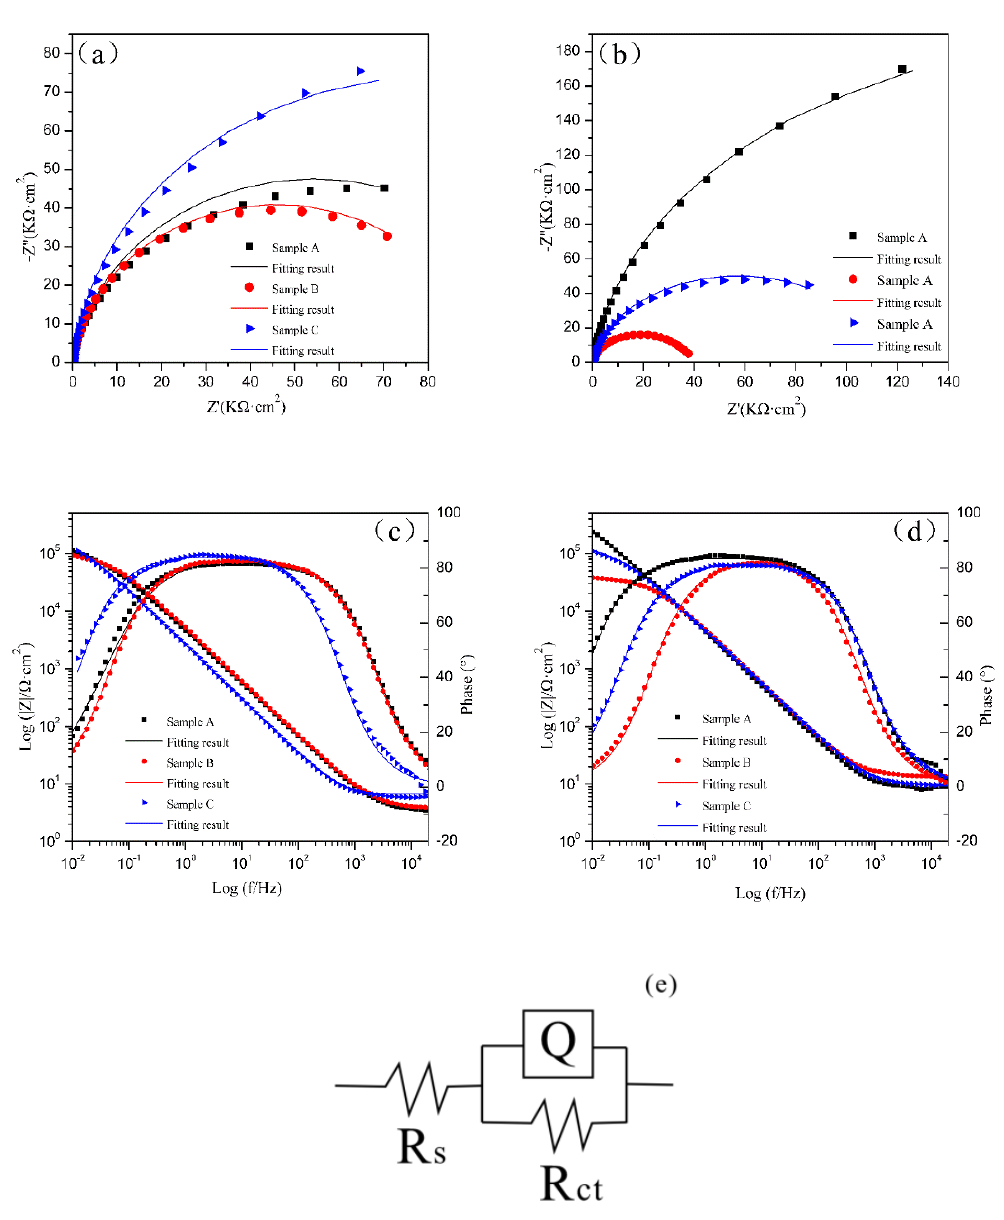
Figure 7. The EIS measurements of SLM-produced Ti-6Al-4V samples with di ff erent build orientations: cross section ( a ) and longitudinal section ( b ) of Nyquist plots, cross section ( c ), and longitudinal section ( d ) of Bode plots and the equivalent circuit model ( e ). Table 4. Fitting parameters of EIS measurements for the cross section and longitudinal section of SLM-produced Ti-6Al-4V samples with di ff erent build orientations.